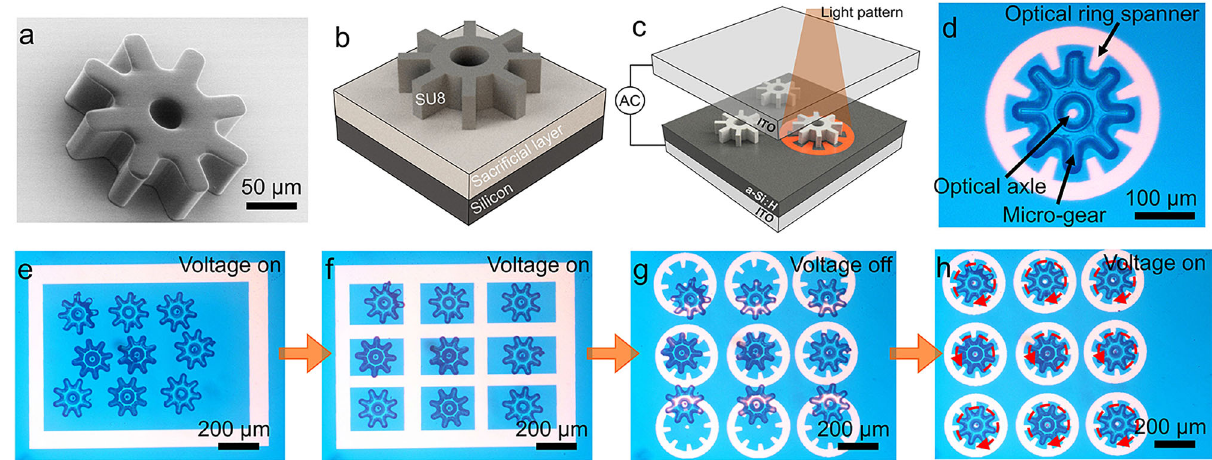
Fig. 1 OET control of micromotors. a SEM image of a 200- μ m-diameter micro-gear. b 3D schematic structure of a micro-gear prior to release. c Schematic depicting the principle of manipulating a micro-gear in an OET device. d Microscope image of a micro-gear being manipulated in an OET device. e – h Frames from Supplementary Movie 3 illustrating the step-by-step process (represented by orange arrows) of manipulating nine micro-gears such that they can be simultaneously rotated. The red-dashed arrows in ( h ) indicate that the micro-gears are rotating clockwise at 60°/s in the upper row, counterclockwise at 60°/s in the mid row, and clockwise at 120°/s in the bottom row. This parallel manipulation process requires ~30 s.